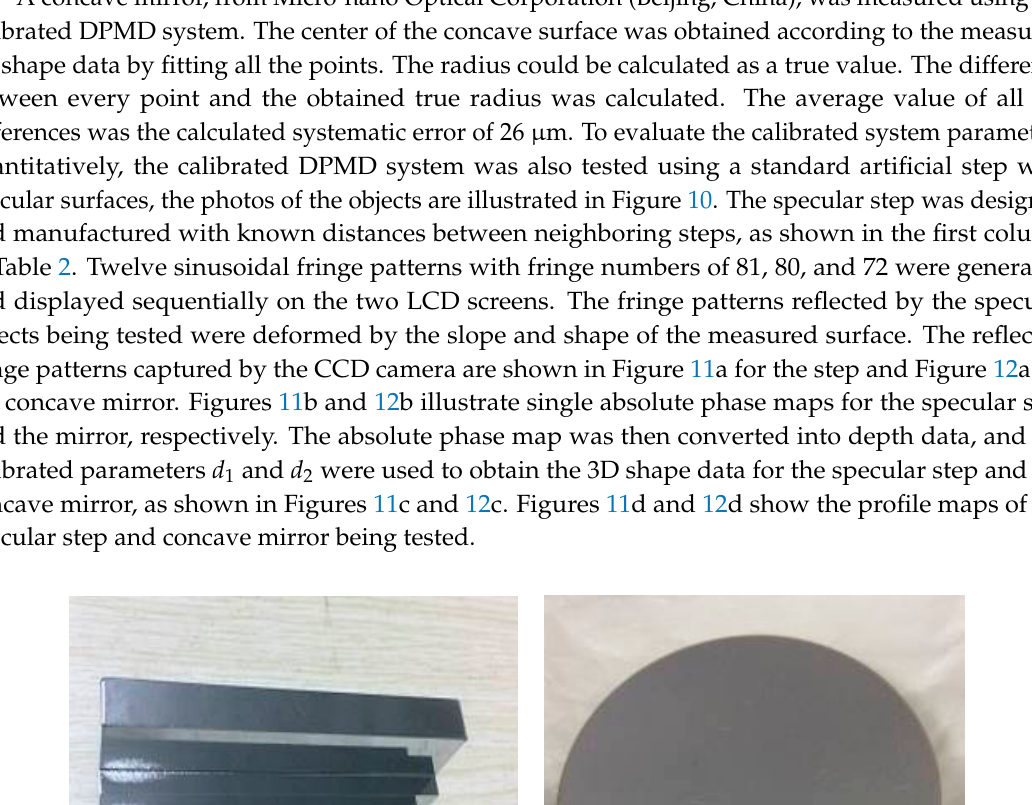
( d ) Figure 11. Measurements on the concave mirror: ( a ) one captured fringe pattern reflected by the concave mirror; ( b ) one absolute phase map from the reflected fringe patterns; ( c ) measured 3D shape of the mirror and ( d ) profile map of the mirror.